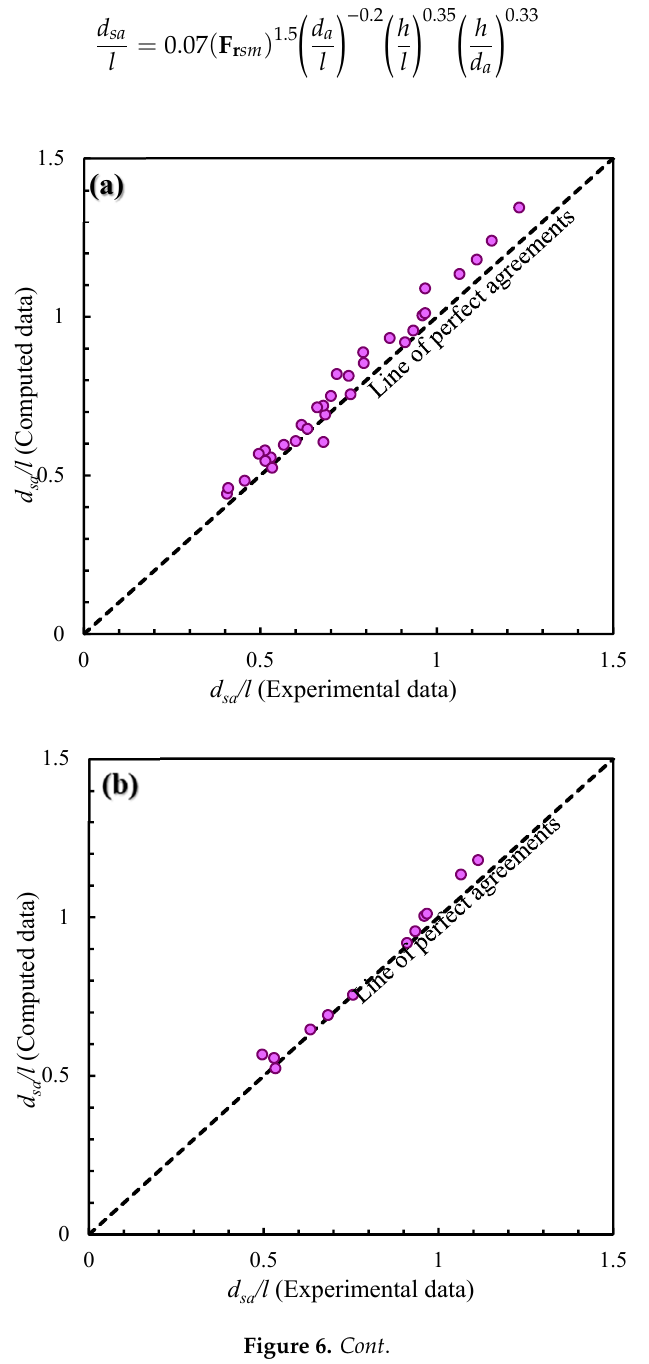
d /l (Experimental data) sa Figure 6. Cont